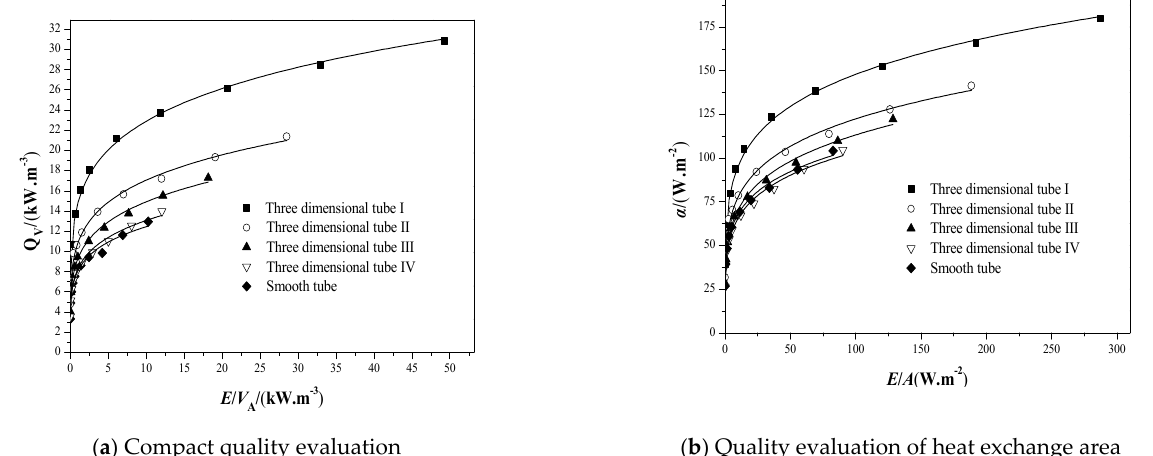
Figure 7. Comparison of spatial volume saving and heat transfer area saving among four types of tube.